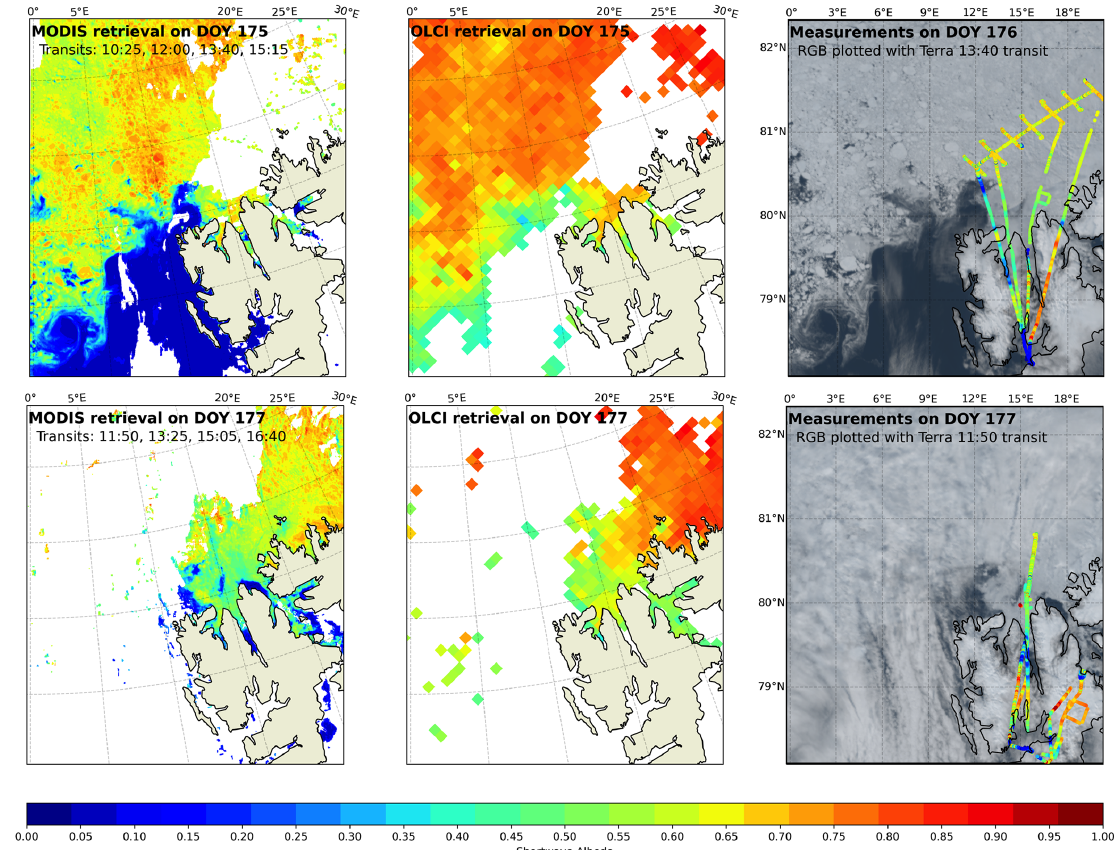
Figure 17. Maps of albedo derived using RTM–SciML (MODIS data) and the MPD algorithm (OLCI data, Istomina, 2020). The top panels depict albedo values on 24 June 2017, while the bottom panels depict values on 26 June 2017. From left to right, panels depict retrievals using RTM–SciML, MPD, and pyranometer measurements layered on an RGB image. On the associated images, the MODIS transits used to retrieve albedo and plot the RGB are labeled. Notably, no OLCI retrieval was available on 25 June 2017, and the campaign measurements for reference were taken on 25 and 26